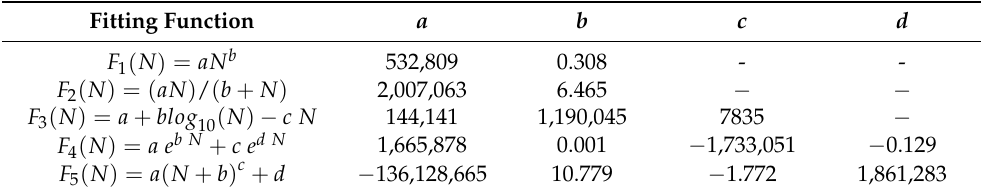
Table 2. Fitted functions’ parameters for Set 1 of hypervolume